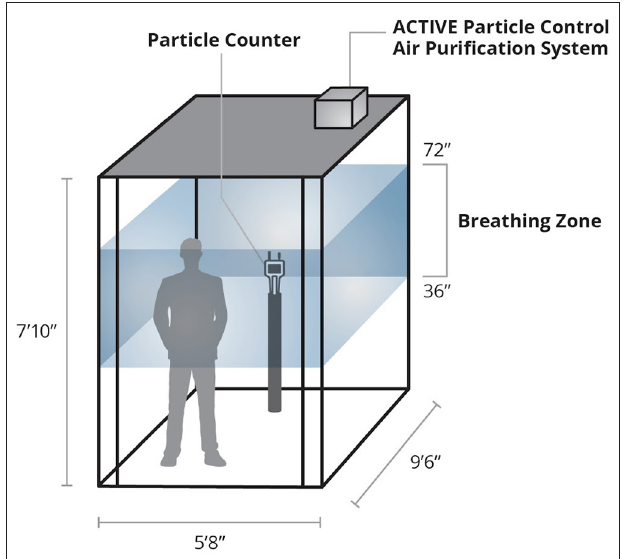
FIGURE 1 | Experimental schematic including placement of indoor air particle counter and ACTIVE Particle Control TM unit.